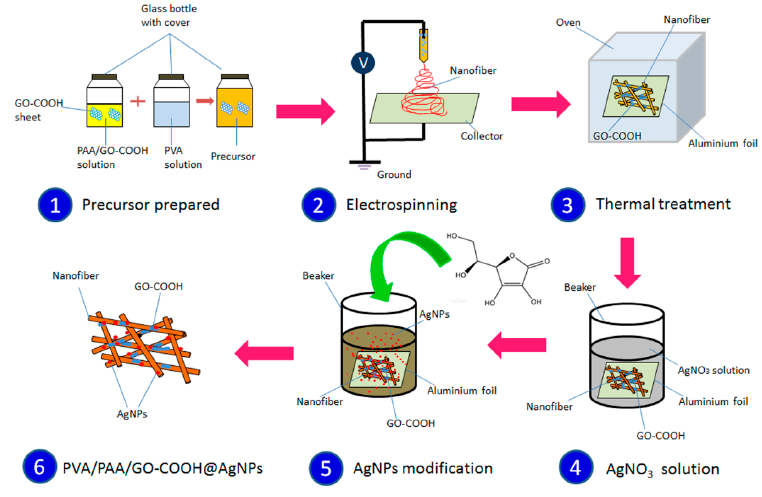
Figure 1. Schematic illustration of the fabrication of PVA/PAA/GO-COOH@AgNPs nanocomposites by electrospinning and thermal treatment.